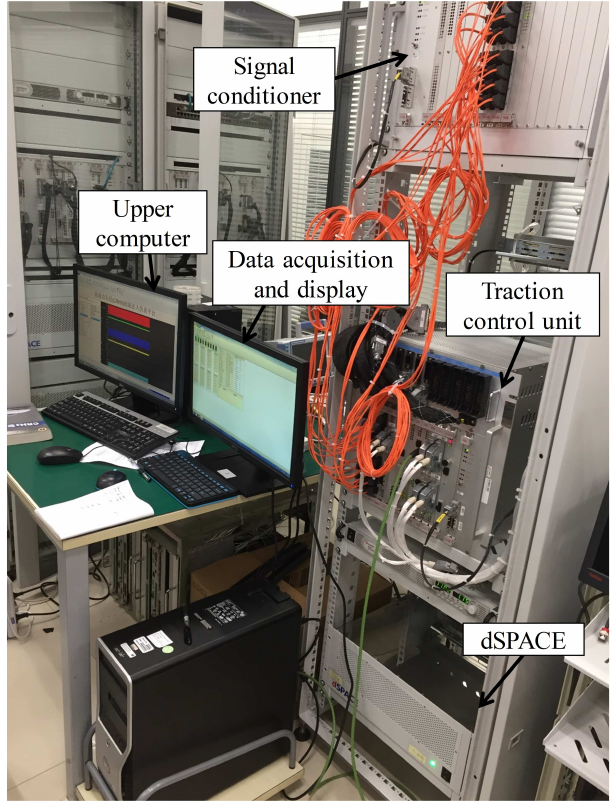
Figure 1. Small sensor information fusion